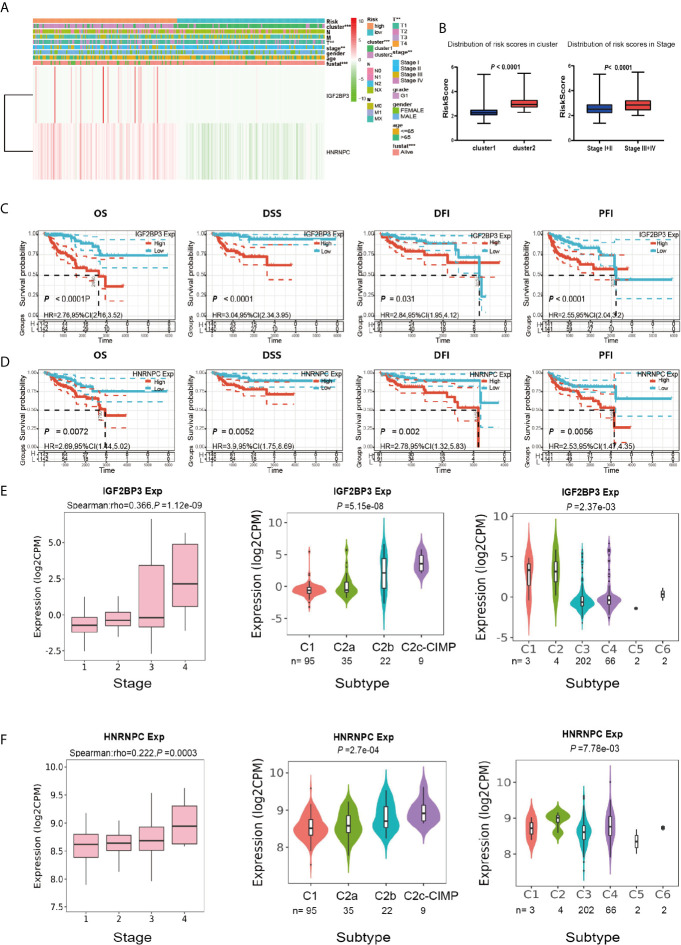
Prognostic risk scores and two prognostic genes showed strong associations with clinicopathological features in PRCC. (A) Heat map of the two gene expressions in the high-risk and low-risk groups. **P < 0.01, and ***P < 0.001. (B) The distribution of risk scores in different pathological stages and clusters. (C) The OS, DSS, RFS, and PFI based on IGF2BP3 expressions. (D) The OS, DSS, RFS, and PFI based on HNRNPC expressions. (E) The IGF2BP3 expression in different subtypes of the stage, molecular and immune. (F) The HNRNPC expression in different subtypes of the stage, molecular and immune.